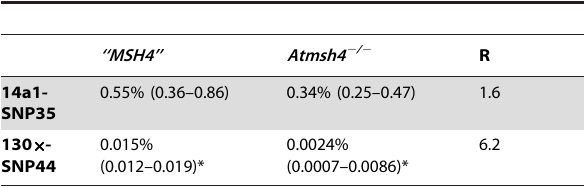
Table 3. NCO rates in ‘‘MSH4’’ and Atmsh4 2 / 2 at 130 6 and 14a1.